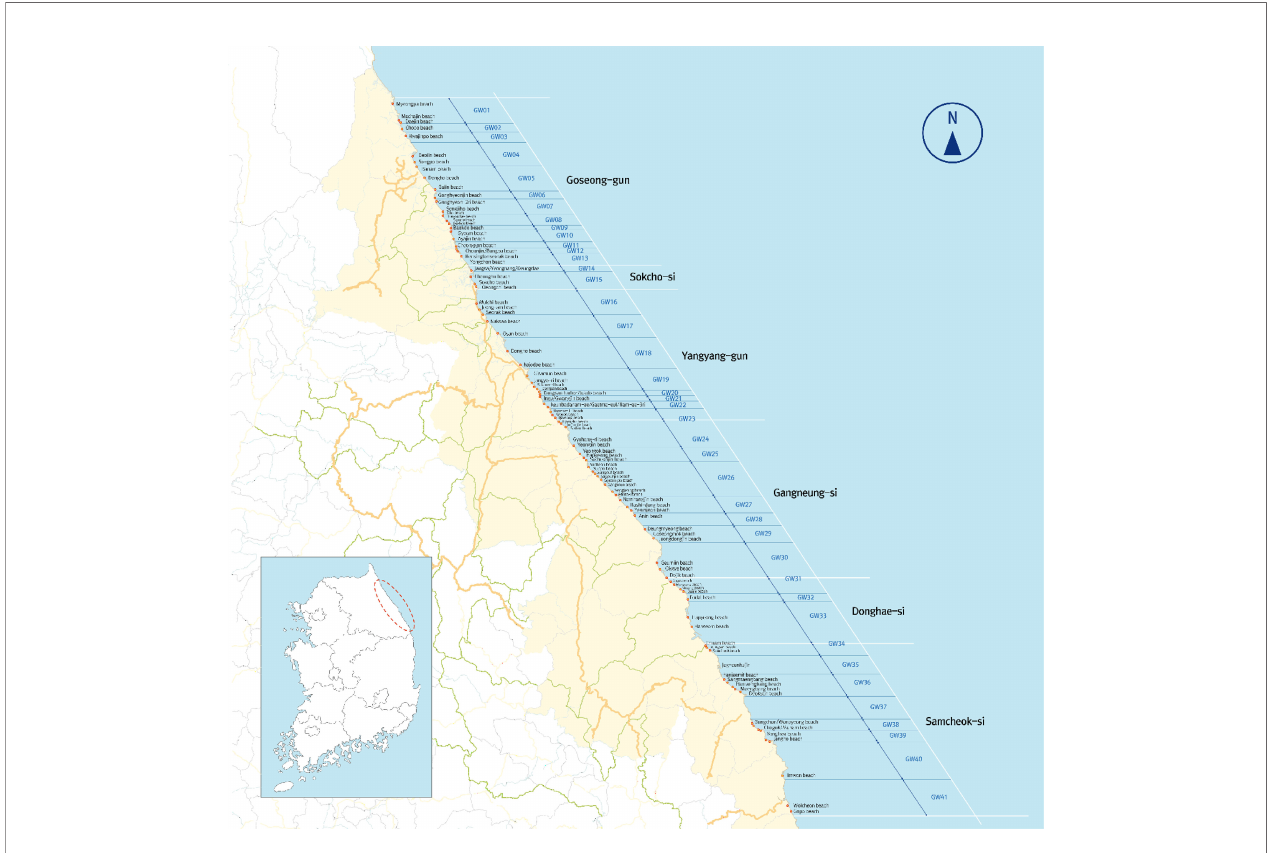
FIGURE 3 | Location of littoral cells in Gangwon-do (The province of Gangwon,